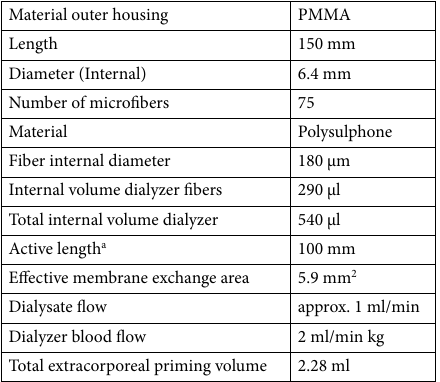
Table 1. Technical specifications of the micro-dialyzers used in the experiments. All components have been built and designed in-house, polysulphone fibers were harvested from conventional clinical hemodialyzers. a Length of dialyzer fibre section involved in fluid/solute